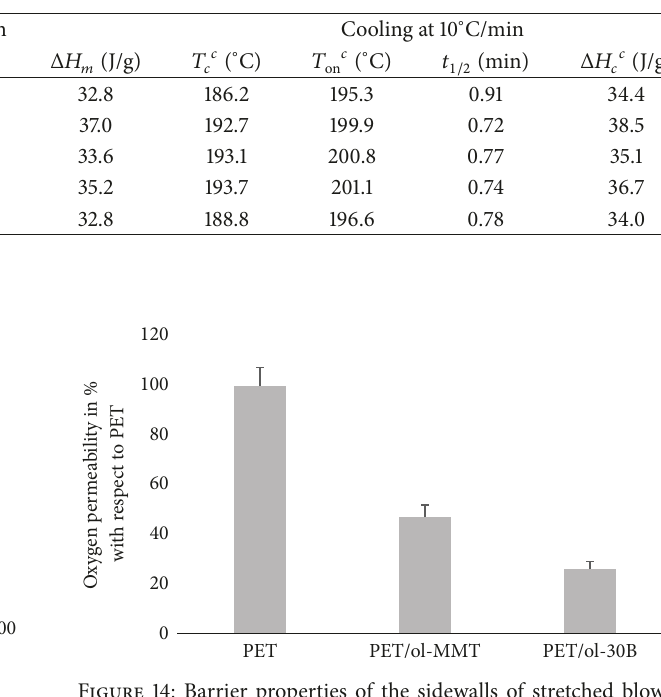
Figure 14: Barrier properties of the sidewalls of stretched blown PET and nanocomposite